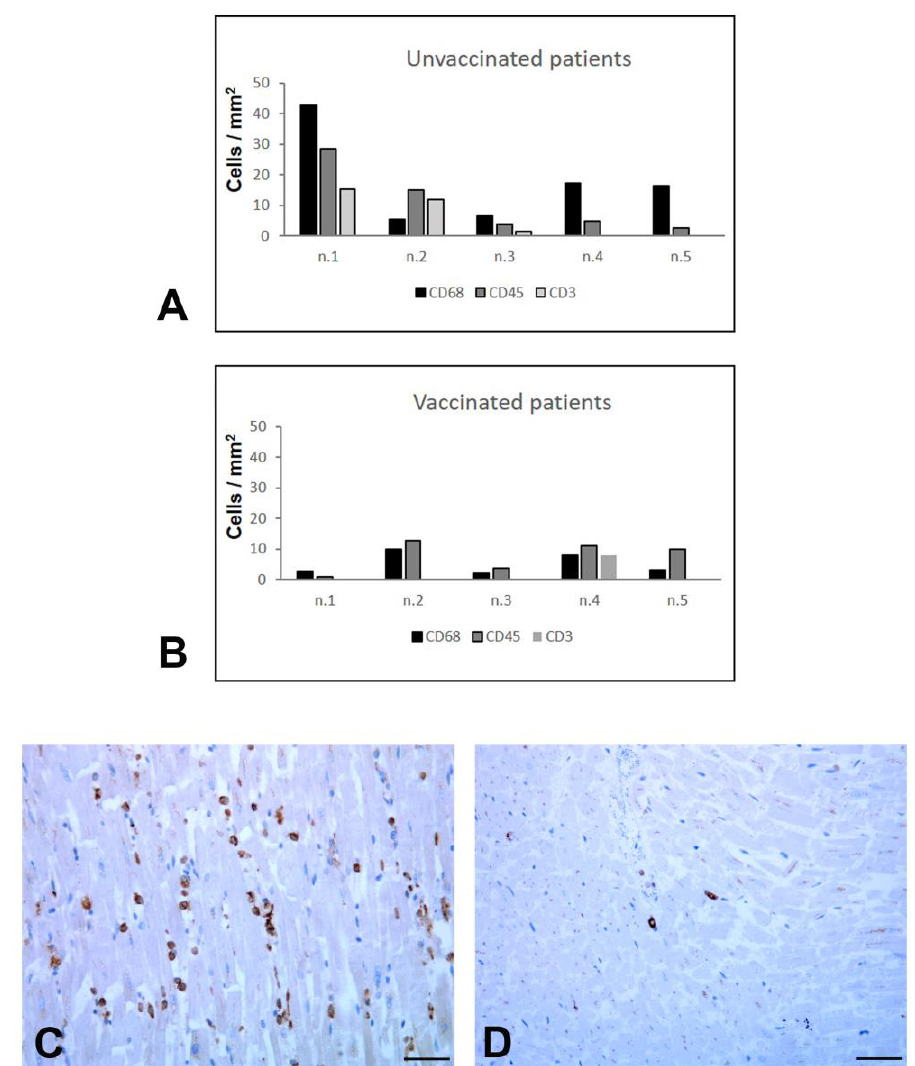
Figure 4. Inflammatory cells immunemcharacterization in myocardial tissue. ( A , B ) Quantification of the number of extravascular CD68+ macrophages, CD45+ leukocytes, and CD3+ T lymphocytes. Unvaccinated and vaccinated patients display a different pattern of inflammatory cells. For each case (n.1–n.5) the mean number of cells per mm 2 is reported. ( C , D ) Representative images of anti- CD68 immunohistochemistry. ( C ) The immunolabelling of myocardial tissue from unvaccinated patient highlights the presence of numerous macrophages. ( D ) Rare CD8-positive cells are visible in myocardial tissue from vaccinated patient. Scale bars: ( C , D ) = 28 μm.